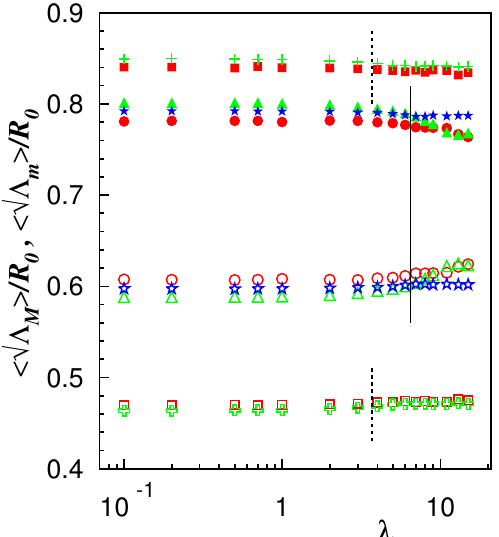
√ √ Λ Λ (cid:105) (filled symbols) and (cid:104) m (cid:105) M